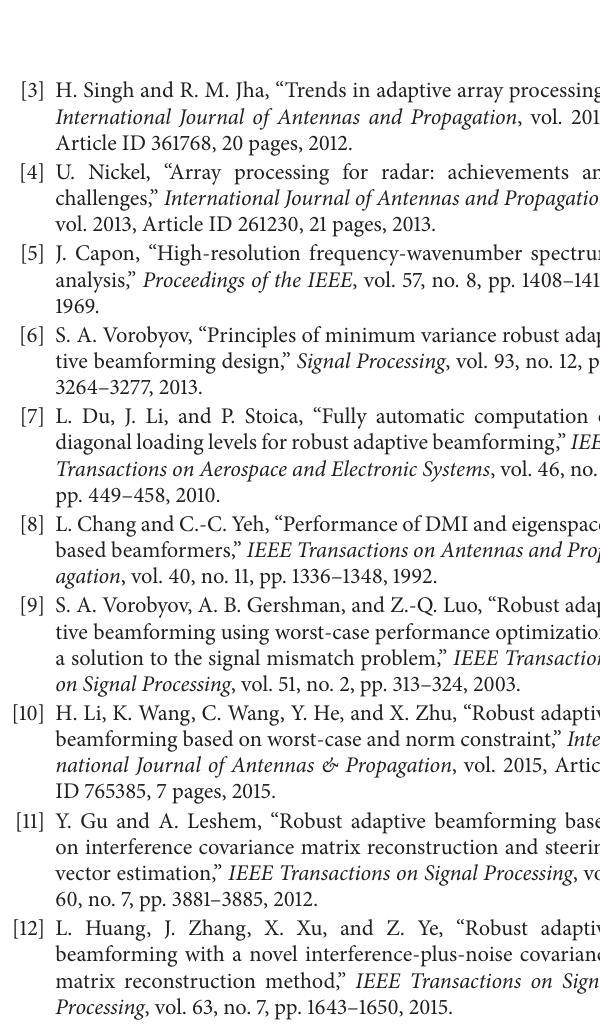
Figure 6: Performance of the beamformers for the case of mismatch due to signal direction error. (a) Output SINR versus 𝜉 . (b) Output SINR versus Δ for training data size of 𝐾 = 50 and INR = 20 dB and SNR = 10